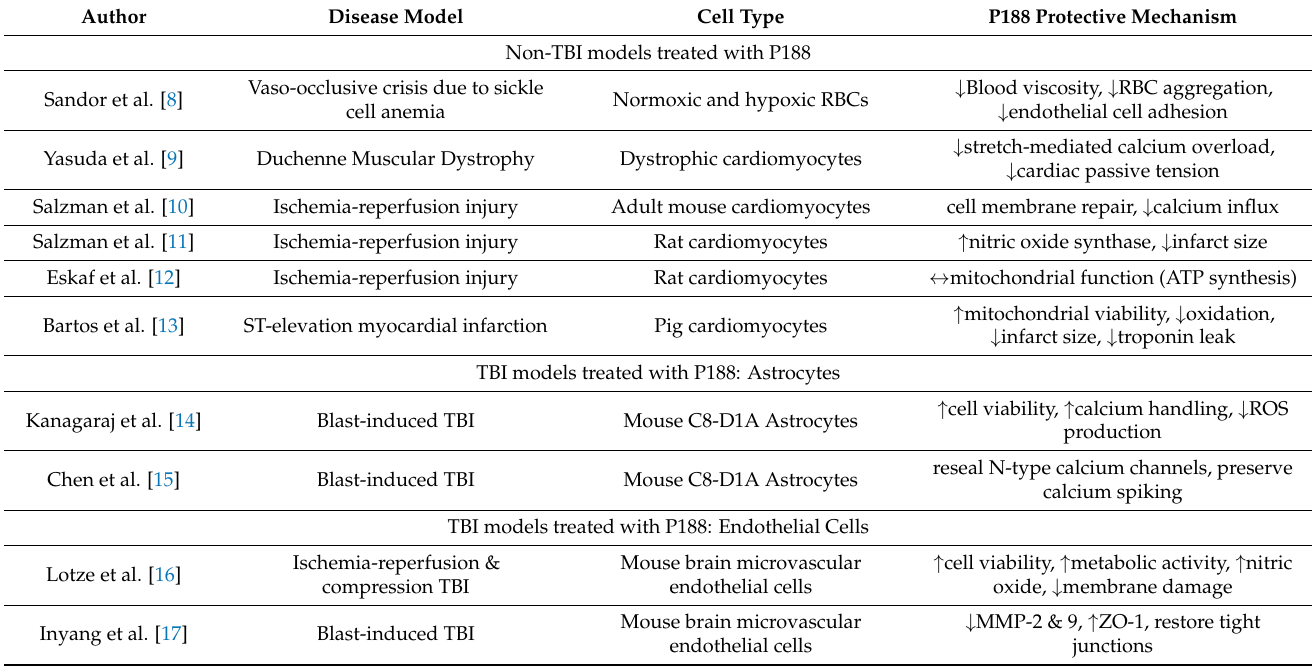
Table 1. Mechanism by which P188 confers protective effects in different cell types/in vitro disease